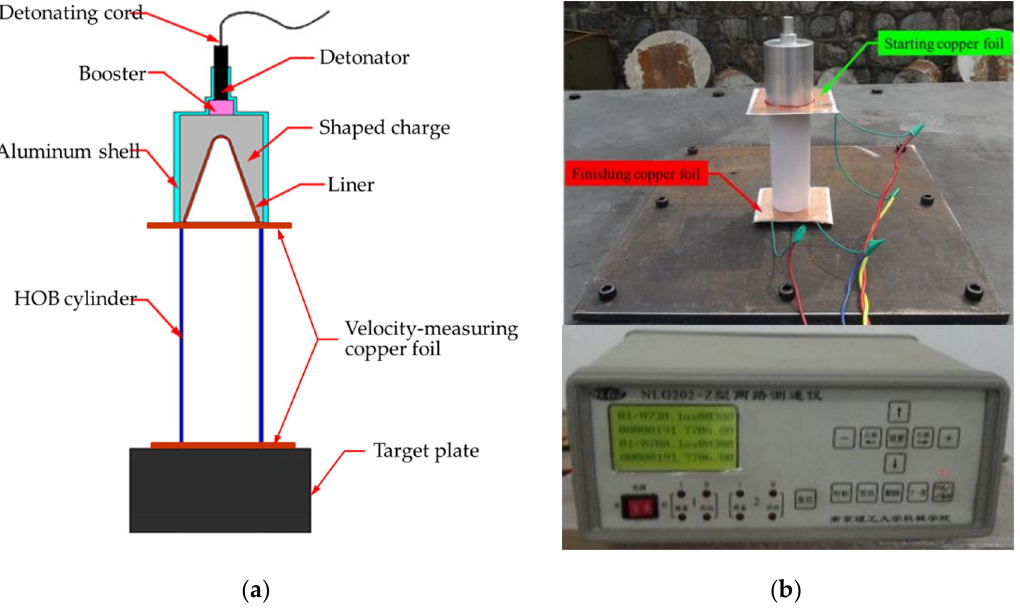
Figure 10. The copper foil target velocity measuring system: ( a ) sketch map of working principle and ( b ) the site layout of the system.